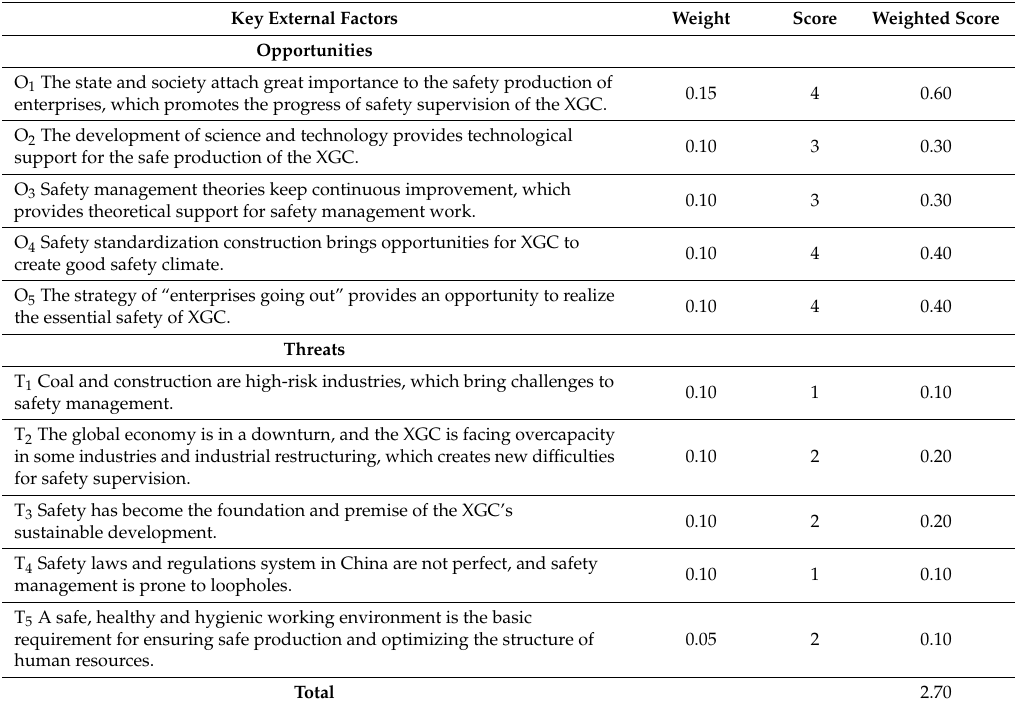
Table 3. External factor evaluation matrix (EFEM) analysis.